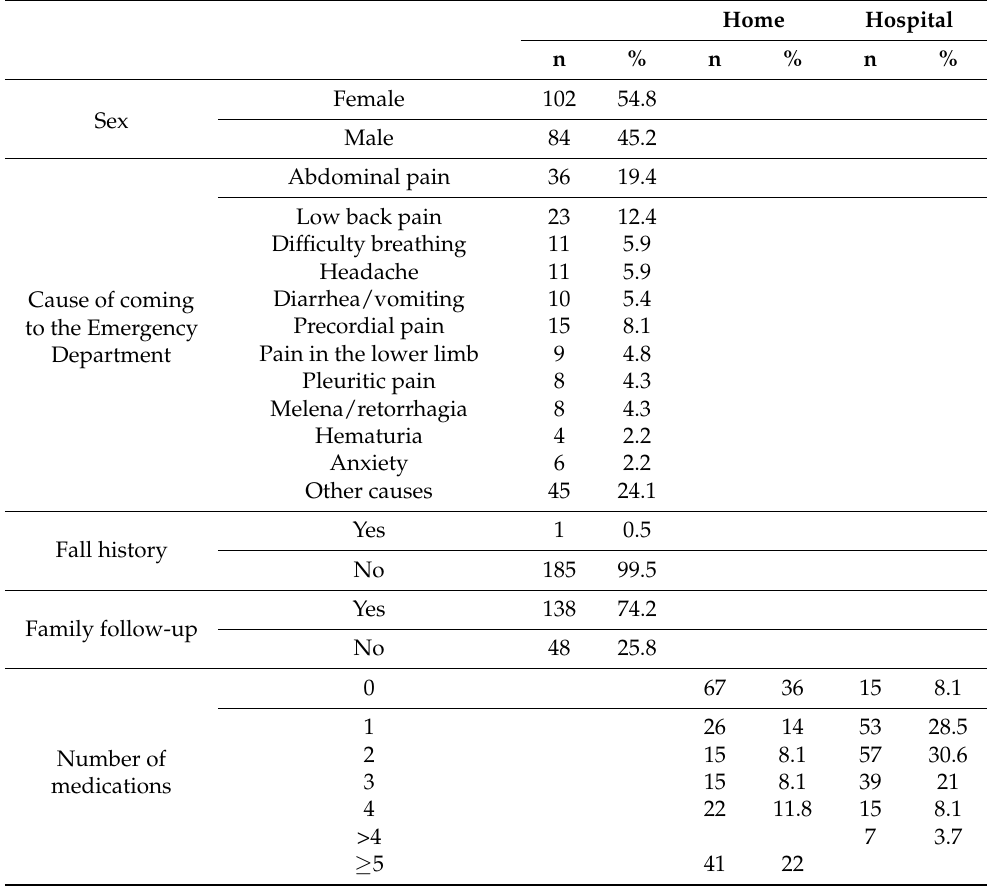
Table 1. Distribution of sample responses regarding sociodemographic and clinical characteristics and history of falls.